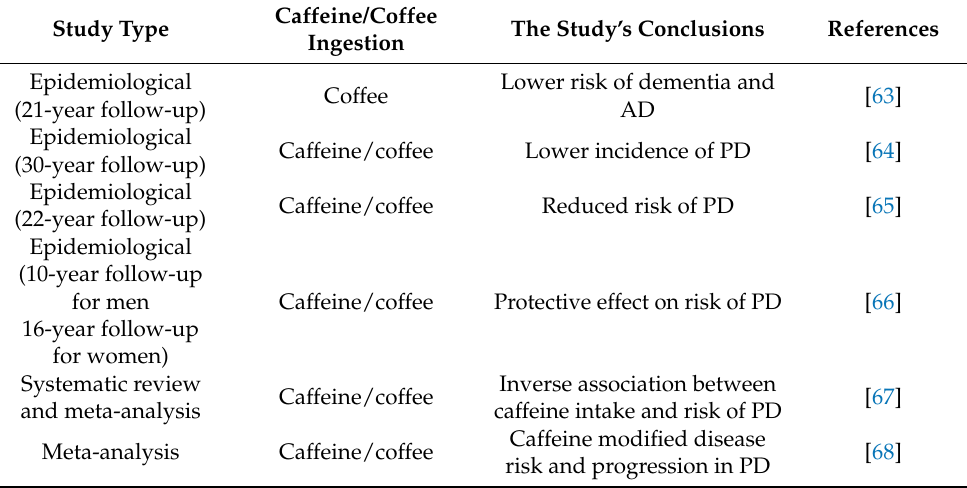
Table 2. The association of caffeine/coffee intake with the risk of neurodegenerative